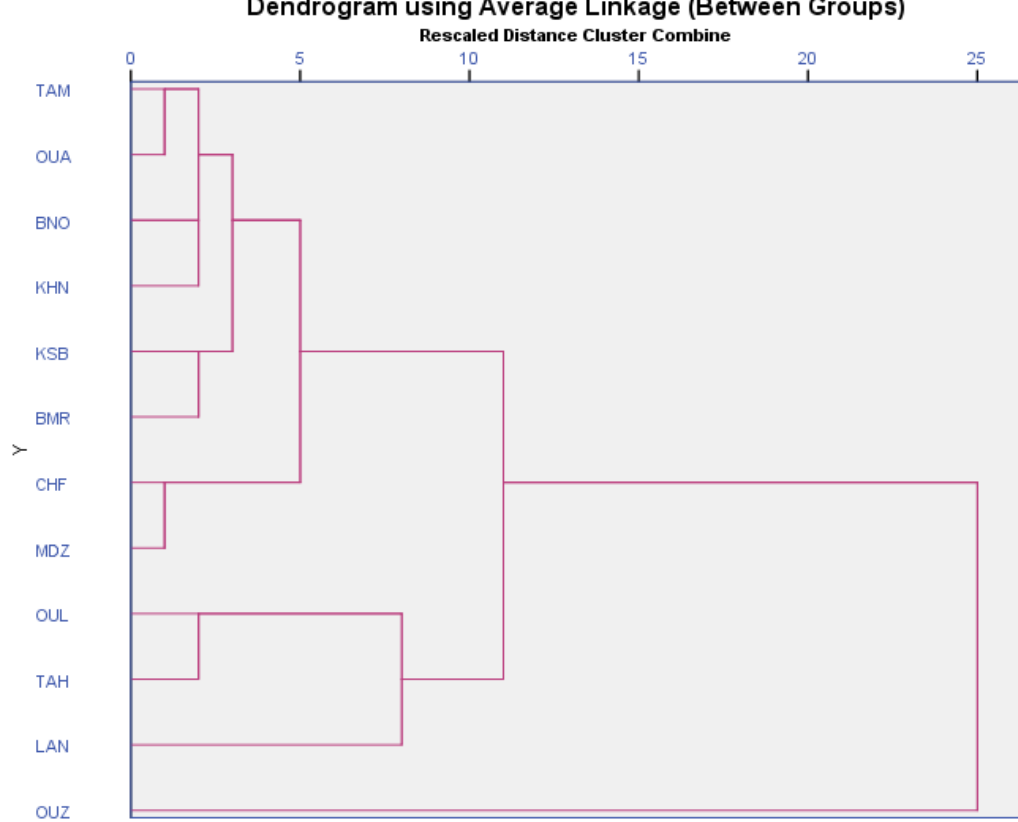
Figure 3. Cluster analysis of the studied genotypes based on the biochemical analysis using squared Euclidian distance method.